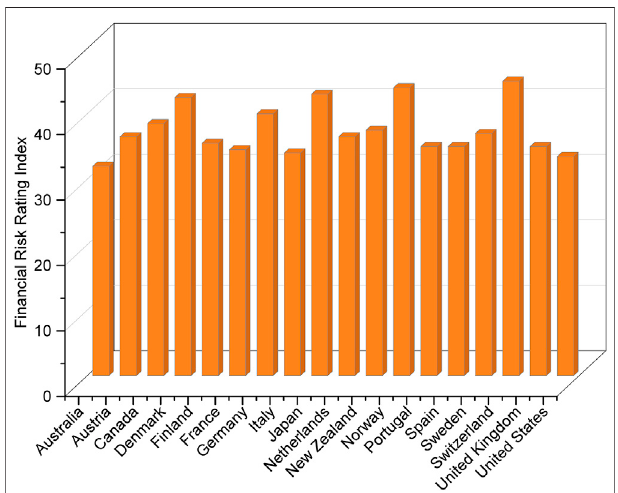
FIGURE 3 | Financial risk rating index of OECD economies for the year 2018. Data source: ICRG (2021)